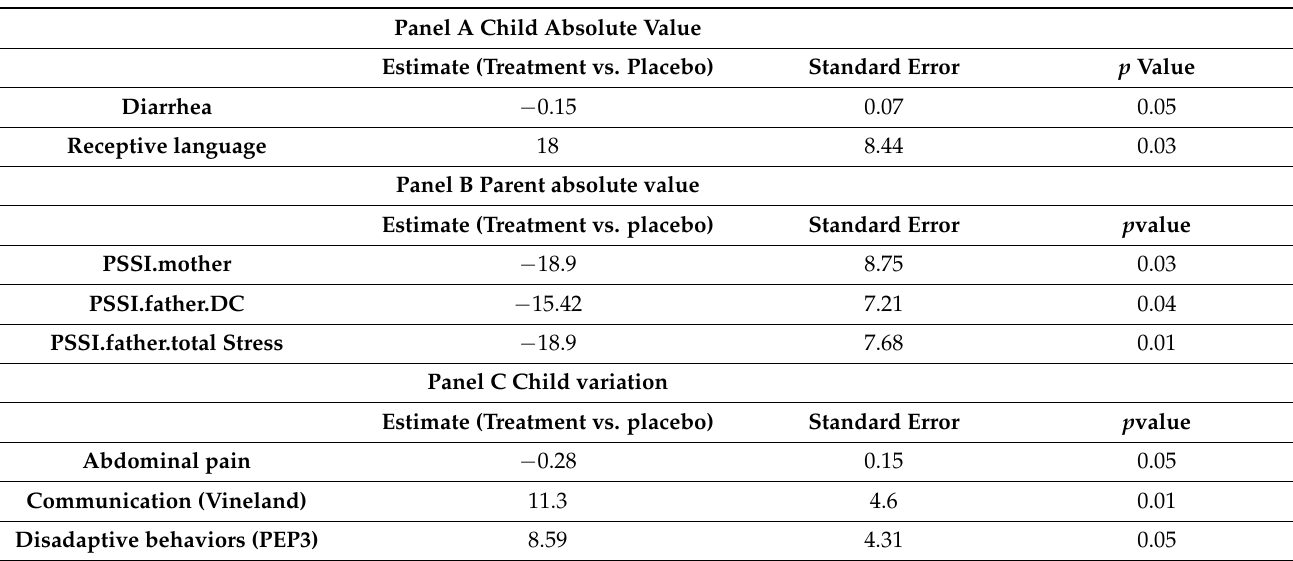
Table 2. Generalized linear mixed model treatment effect estimate (GLMM) with standard error (SE) and p-values. Panel A reports the child’s specific outcomes; panel B shows the parental outcomes; and Panel C details the delta